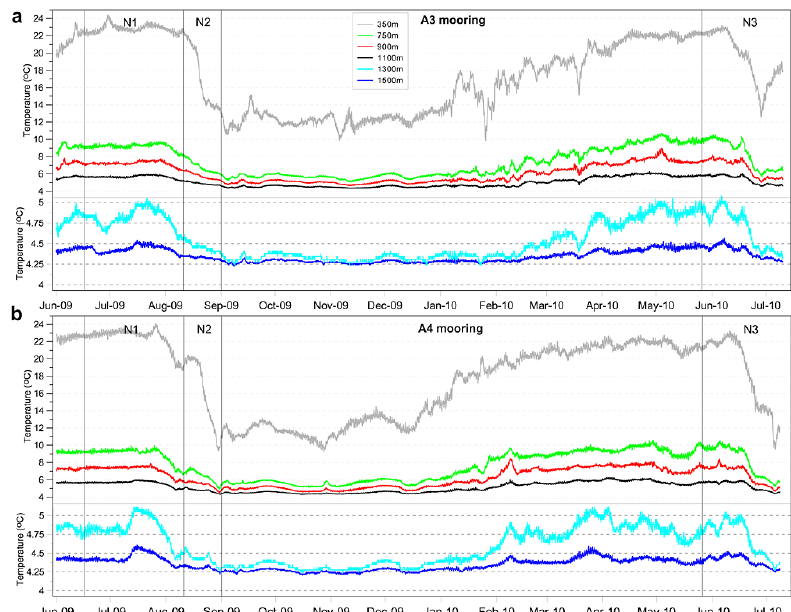
Figure 8. Sea temperature ( ◦ C) temporal evolution at several depths (350, 750, 900, 1100, 1300, and 1500m) from (a) A3 and (b) A4 moorings (Fig. 1) from June 2009 to mid-July 2010. The 1300 and 1500m time series are plotted with a different y axis for clarity reasons. The LCFE N1, N2, and N3 periods are indicated with black solid vertical